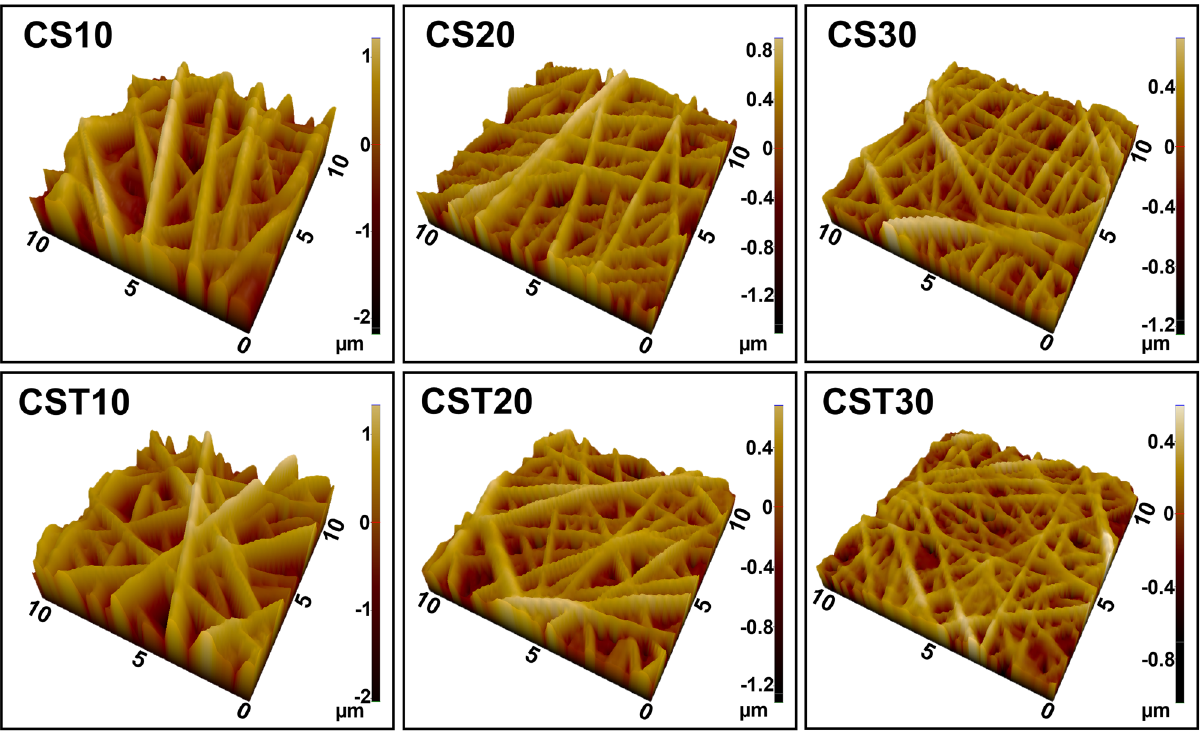
Figure 5: AFM images of the nano fi ber mats with and without T80